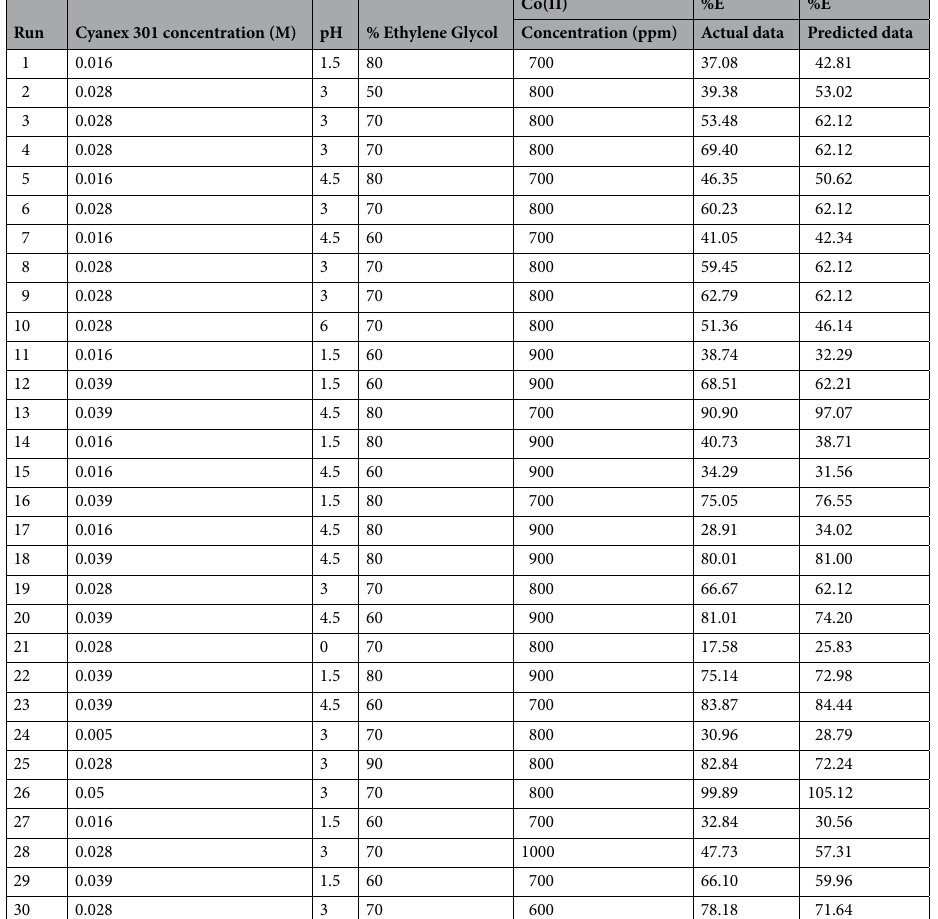
Table 2. Conditions of thirty designed experiments with obtained